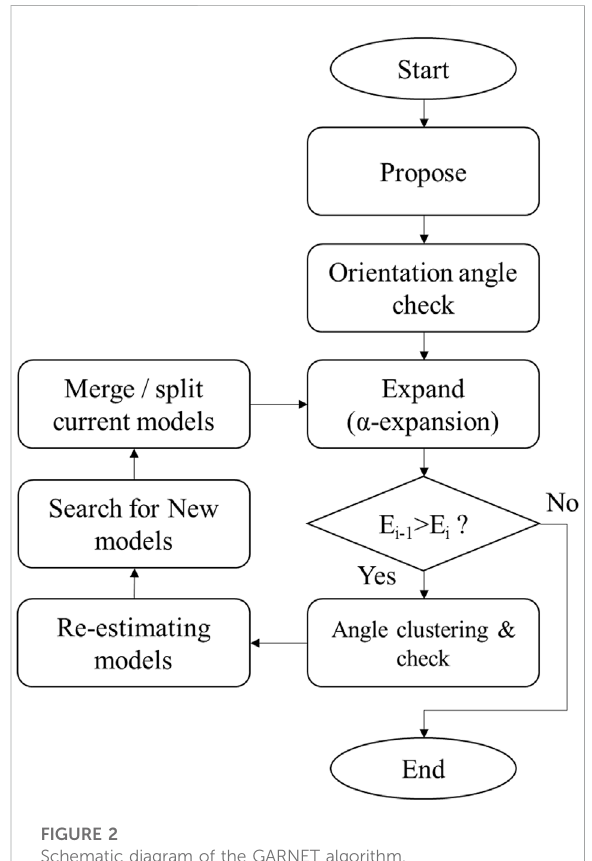
FIGURE 2 Schematic diagram of the GARNET algorithm.